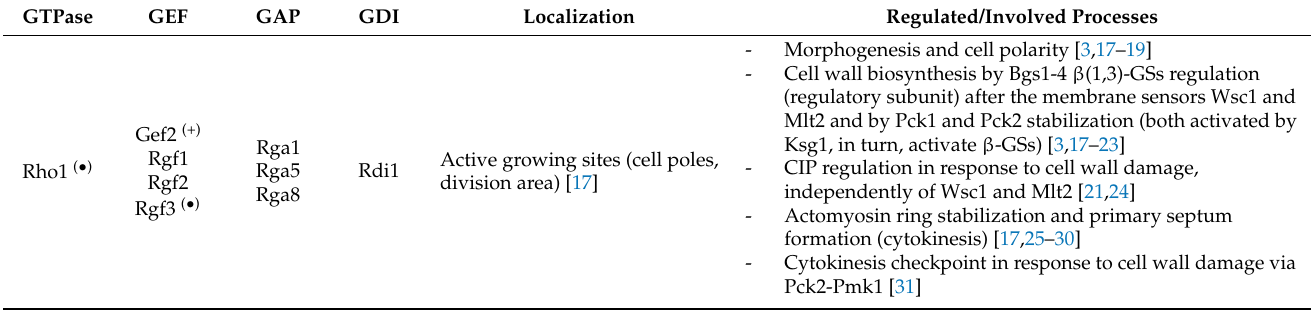
Figure 1. S. pombe Rho GTPases and their regulators. See main text and tables for details on each protein. Table 1. Rho GTPases in fission